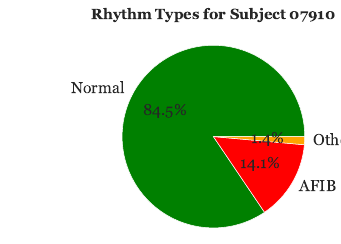
Figure 5. Sample of rhythm frequencies for Subject 04936 and Subject 07910.